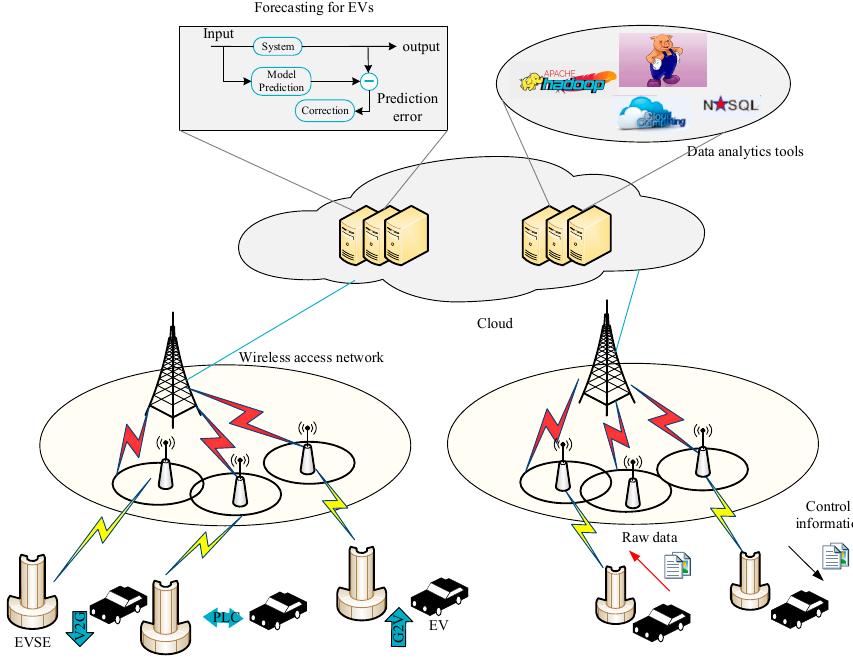
Figure 2. Implementation diagram of electric vehicles (EV) grid integration.